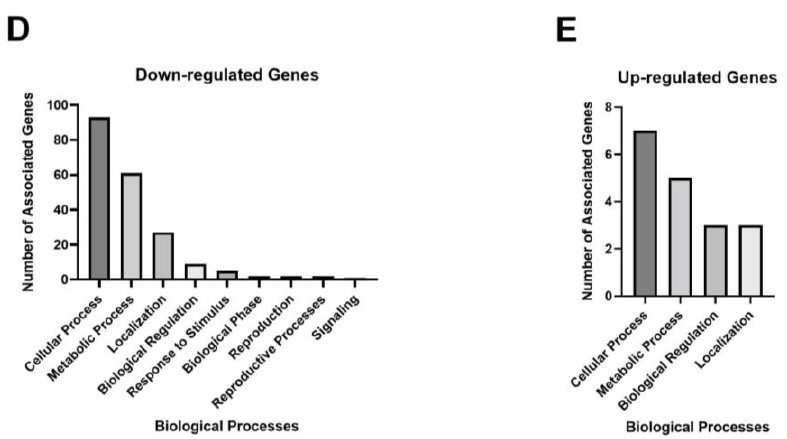
Figure 7. RNAseq analysis. ( A ) A volcano plot showing altered genes in RNA-Seq analysis with red dots indicating genes that have a fold change larger than 1.25 and less than − 1.25 with p − value < 0.05. ( B – E ) Bar graphs represent classes of genes that were differentially expressed due to the treatment of QDs. Each bar is the number of differentially expressed genes in a protein class or associated with a biological process. ( B ) Downregulated genes sorted by protein class. ( C ) Upregulated genes sorted by protein class. ( D ) Downregulated genes are sorted by associated biological processes. ( E ) Upregulated genes sorted by associated biological processes.